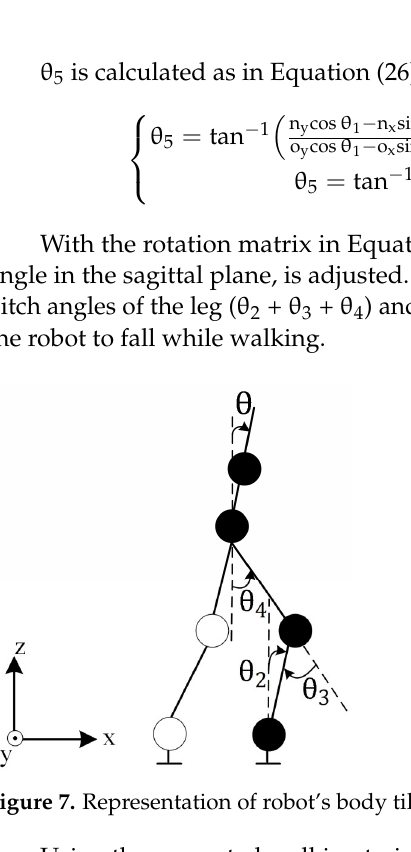
Figure 8. Body tilt angles: ( a ) pitch angle, ( b ) roll angle.